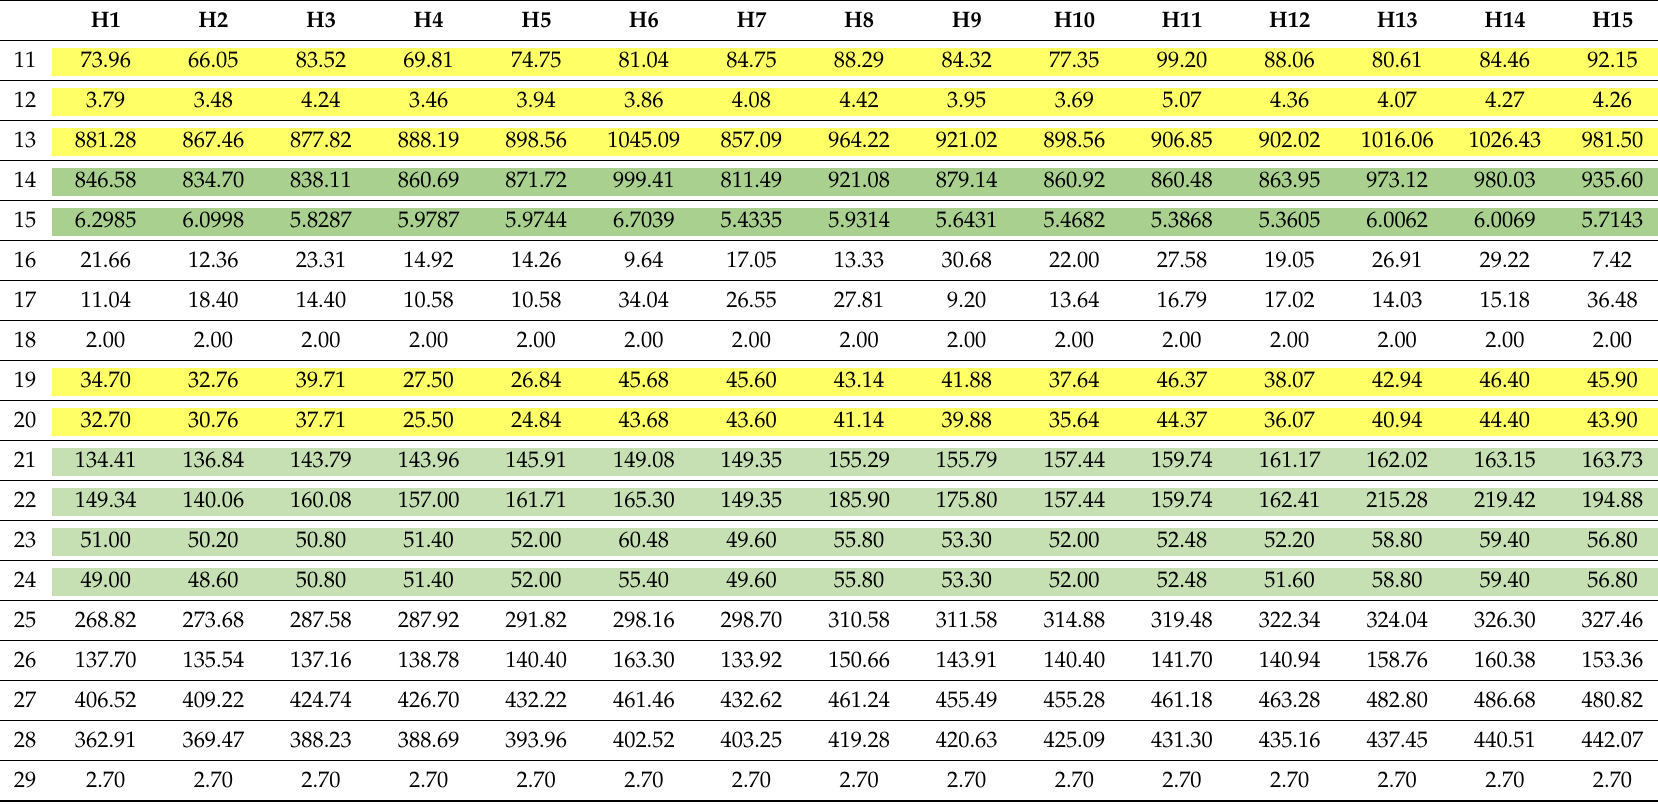
Table A2. Selected parameters of the buildings of the H1–H30 building set (Part II): (11) Envelope building materials: Sum of plain concrete made of natural aggregate, (12) Sum of reinforced rods, (13) Sum of H + H blocks - total area of external walls, (14) External walls (H + H blocks) minus the area of openings, (15) External walls (H + H blocks) minus the area of openings per 1 m 2 , (16) Oknoplast PVC windows, (17) Oknoplast PVC balcony doors, (18) External door, (19) Total area openings, (20) Total area of windows; (21) Base area: polygon A (22) rectangle A R ; (23) Perimeter of the base: polygon P, (24) rectangle P R ; (25) Envelope area: base, (26)